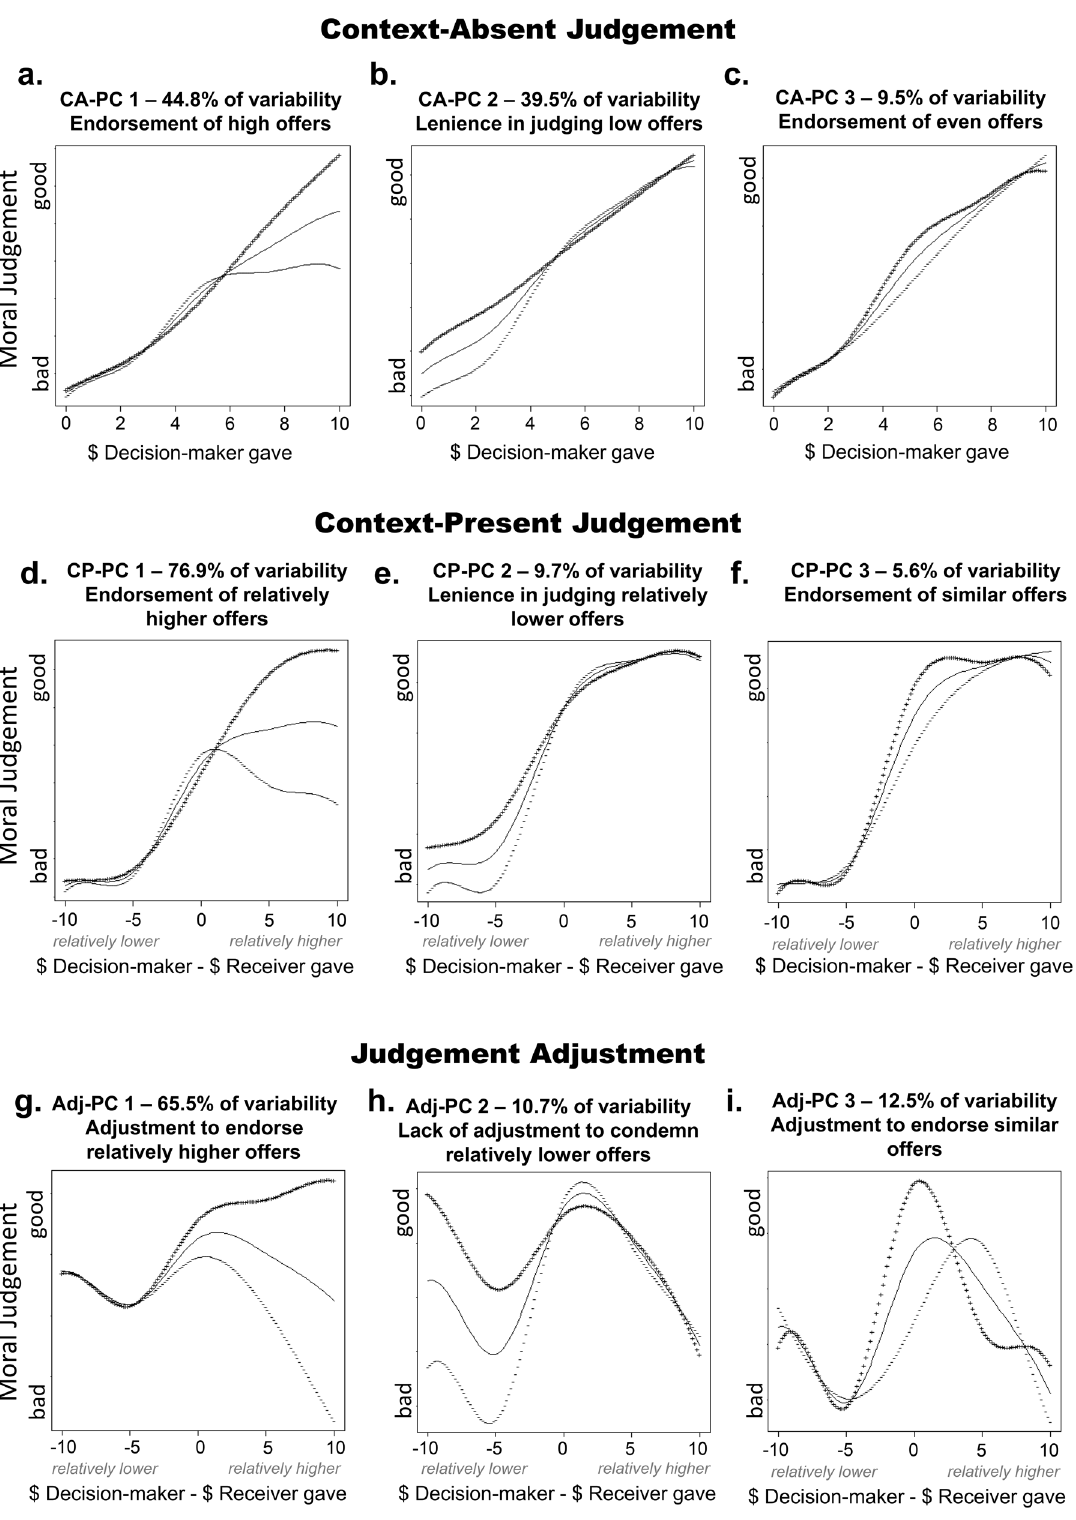
Figure 5. Individual differences in judgement profiles. Principle Components (PC) for context-absent judgements ( a – c ), context-present judgements ( d – f ), and judgment adjustment (context-present judgement— context-absent judgement) response patterns ( g – i ). Mean judgement curves for two judgements are plotted as a continuous line. Curvilinear variability in the data along each principle component is plotted using + and − signs. These two curves are calculated by adding and subtracting 2 standard deviations of each of the principle components to the mean. Values for which these curves diverge denote trial types in which participants’ responses differed according their scores on each principal